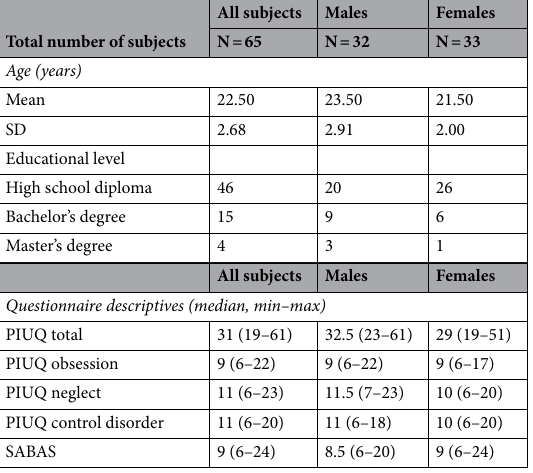
Table 1. Descriptives of subjects’ demographic and questionnaire data. N number of participants; PIUQ Problematic Internet Use Questionnaire; SABAS Smartphone Application-Based Addiction Scale. Due to non- normal distribution, medians and min–max ranges are